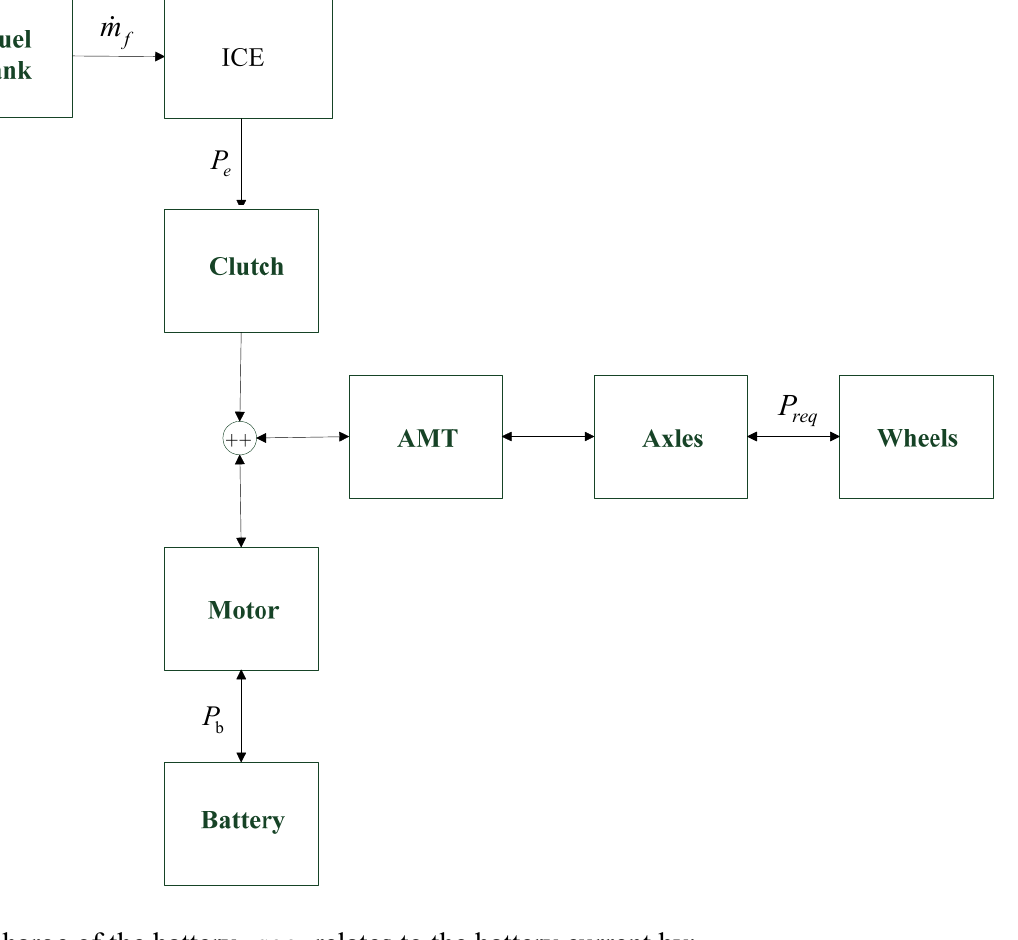
Figure 1. The pre-transmission parallel hybrid electric